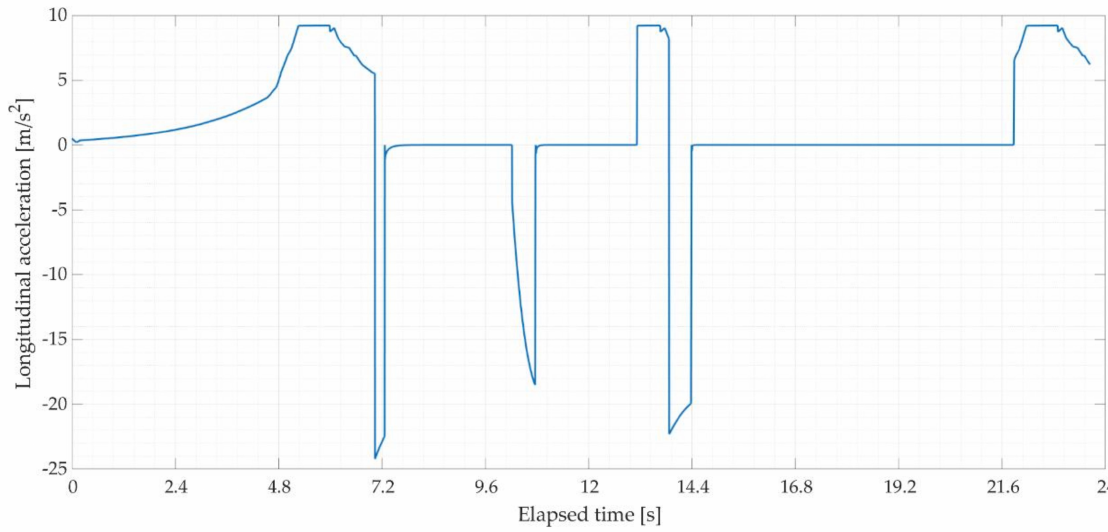
Figure 8. Longitudinal acceleration versus lap